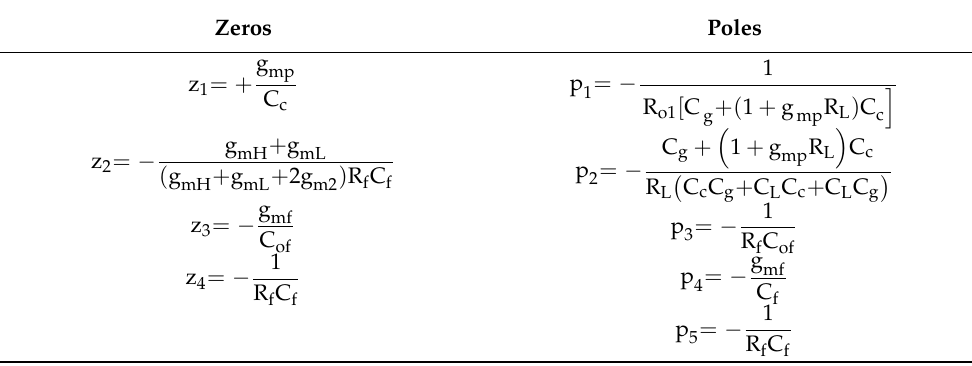
Figure 7. Small signal block diagram of the proposed OCL-LDO. Table 1. Zeros and poles